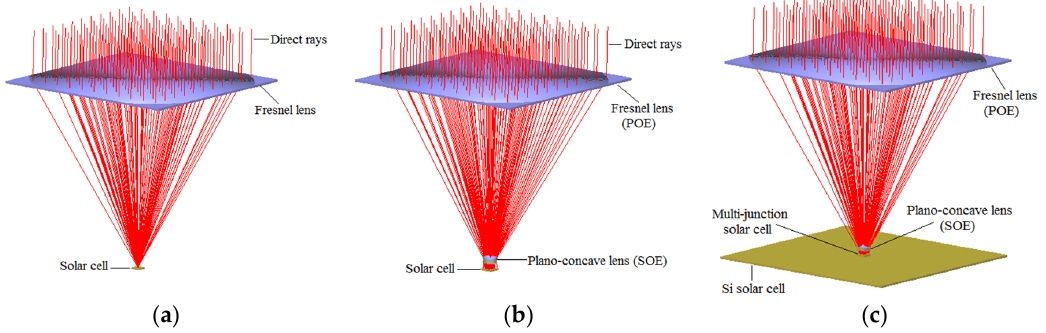
Figure 11. CPV units: ( a ) the CPV unit without the SOE and low ‐ cost cell; ( b ) the CPV unit with the SOE; and ( c ) the designed CPV unit with both the SOE and low ‐ cost cell.